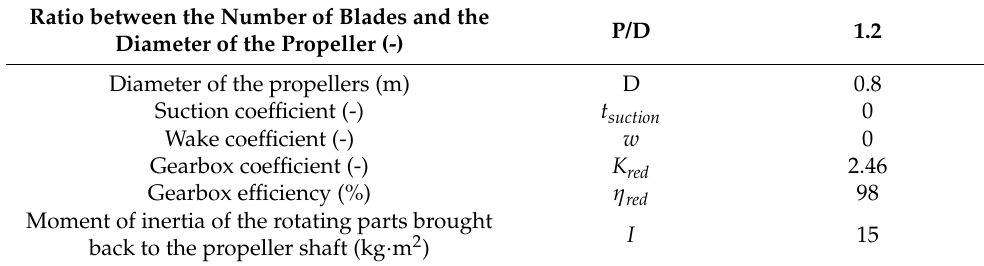
Table 3. Simulation parameters.